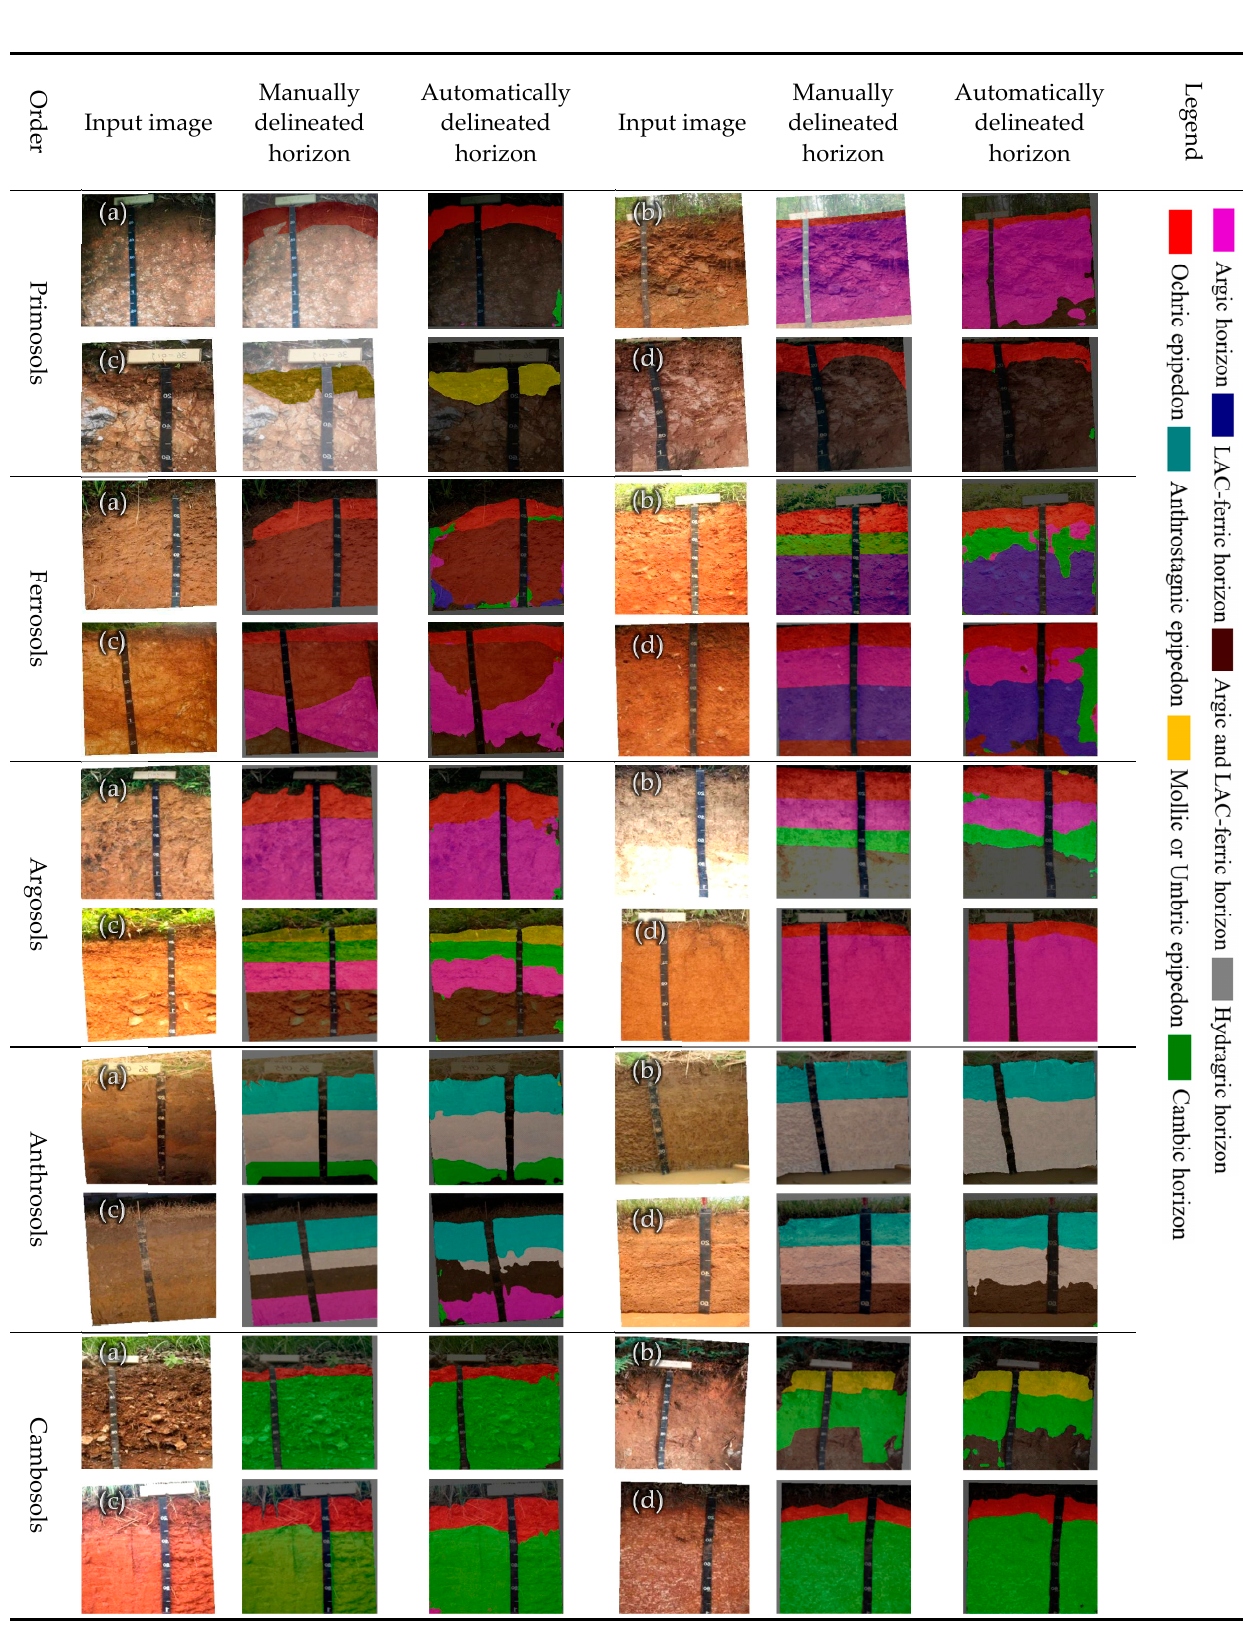
Figure 13. Examples of diagnostic horizon identification model results .